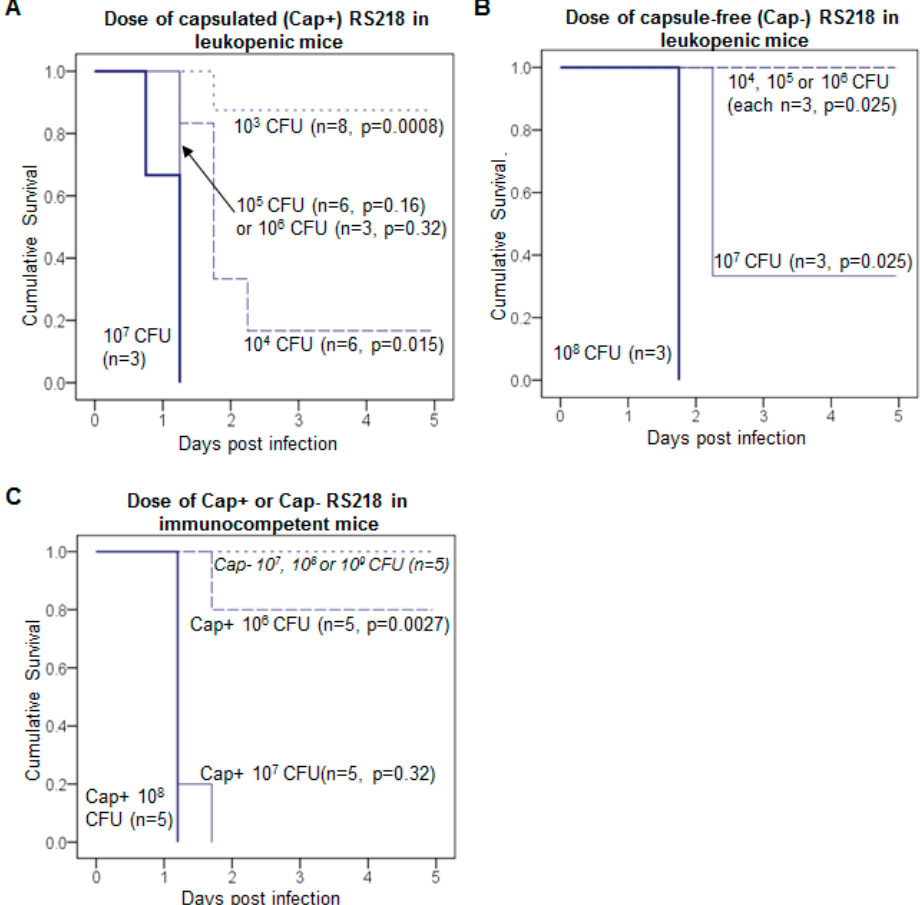
Figure 6. Capsule-free RS218 is avirulent in mice. Kaplan-Meier survival curves of mice per dose of different strains. ( A ) K1-capsulated RS218 (Cap+) in leukopenic mice; ( B ) capsule-free RS218 (Cap − ) in leukopenic mice; ( C ) Cap+ and Cap − RS218 in immune competent mice. The median lethal dose is 10 3 –10 4 CFU for Cap+ and 10 6 –10 7 CFU for Cap- RS218 in leukopenic mice, a difference of 3 orders of magnitude. The median lethal dose in normal mice is 10 6 –10 7 CFU for Cap+ RS218, while Cap − RS218 is not lethal at doses as high as 10 9 CFU. Mouse survival was monitored for 5 days and the cumulative probability of survival was plotted for each dose. The mouse number n of each treatment is labeled by each curve. Log rank test: p values are listed for lower doses compared to the highest dose of each strain.